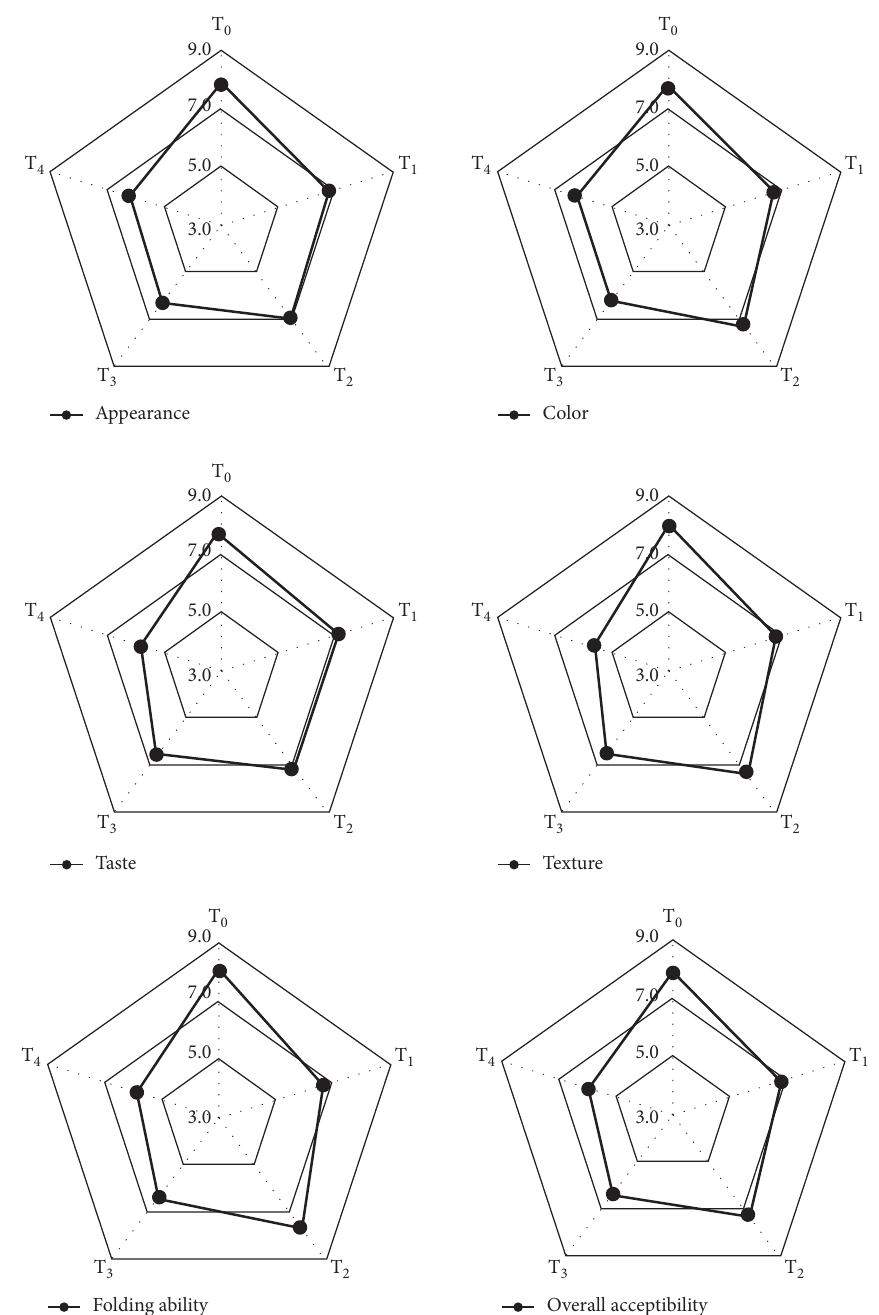
Figure 1: Sensory evaluation of straight-grade flour, raw and processed potato powder, and supplemented